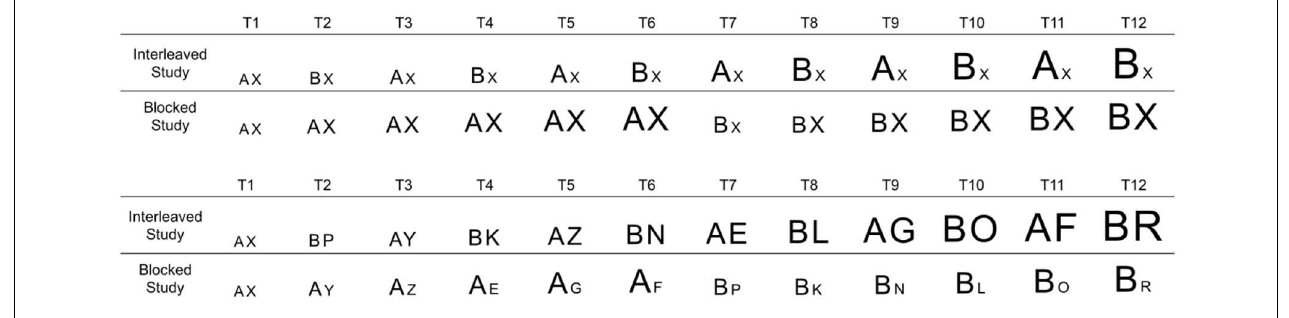
FIGURE 1 | Schematic representation of the “attentional bias framework” for sequential order effects in category learning. Objects are represented by pairs of letters, where each letter refers to a feature. There are two categories; one characterized by the presence of Feature A and the other Feature B, while the category exemplars have other features as well.